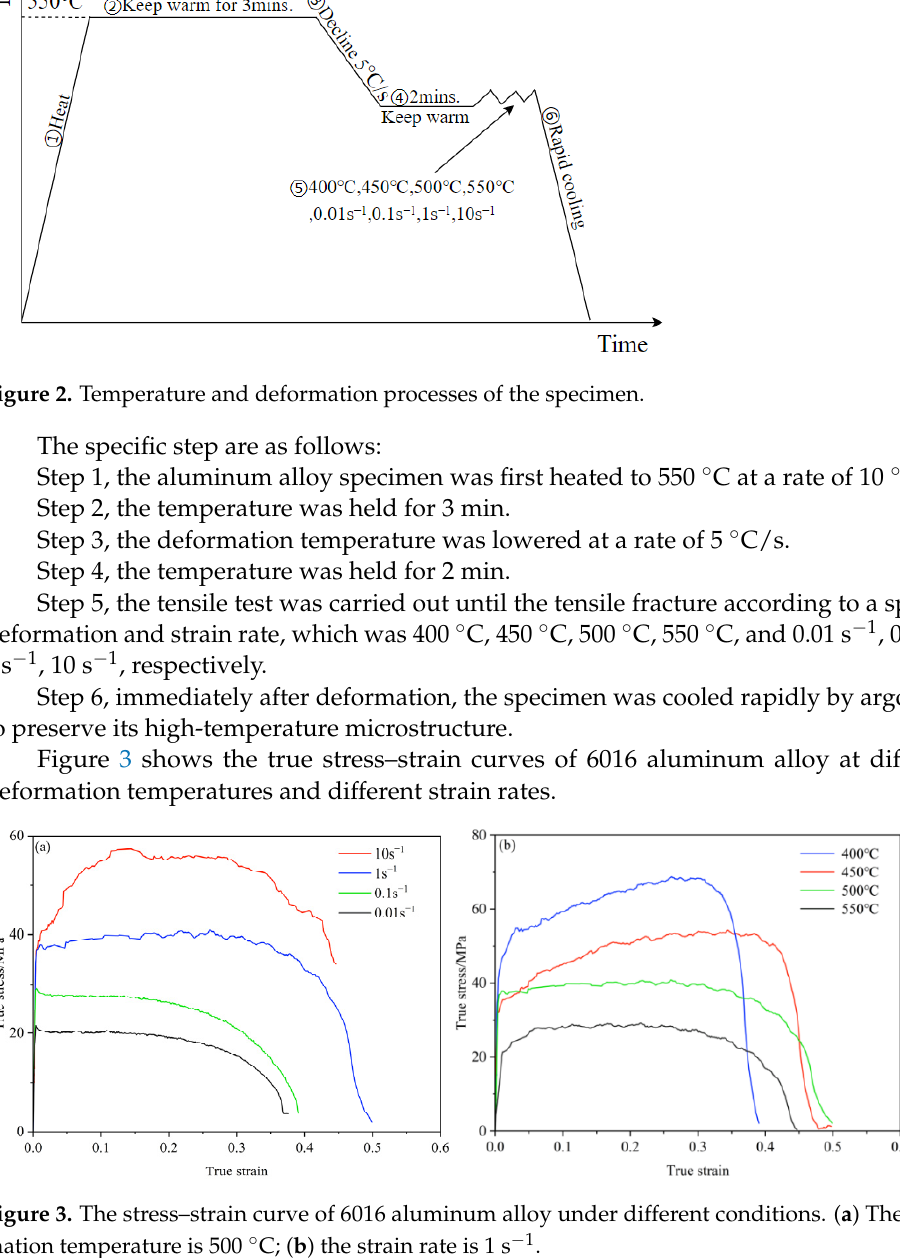
Figure 3. The stress–strain curve of 6016 aluminum alloy under different conditions. ( a ) The defor- mation temperature is 500 °C; ( b ) the strain rate is 1 s − 1 .